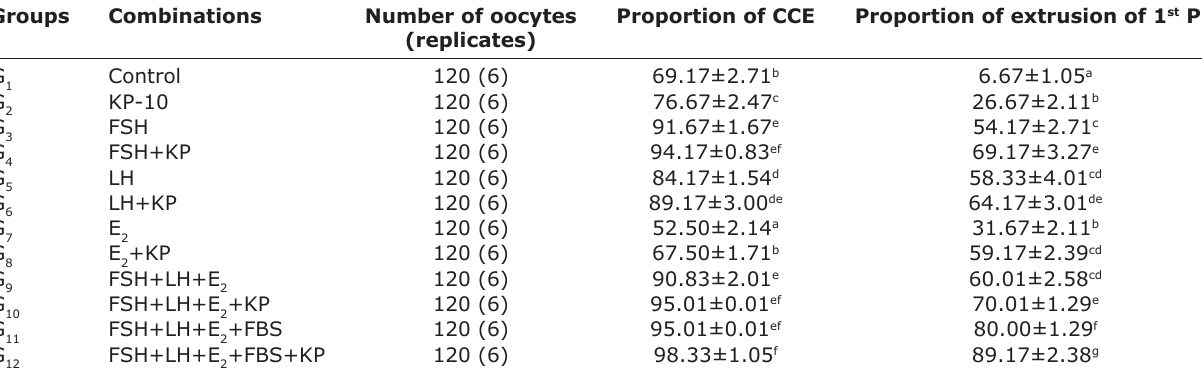
Table-3: Effect of KP in combination with FSH, LH, and E